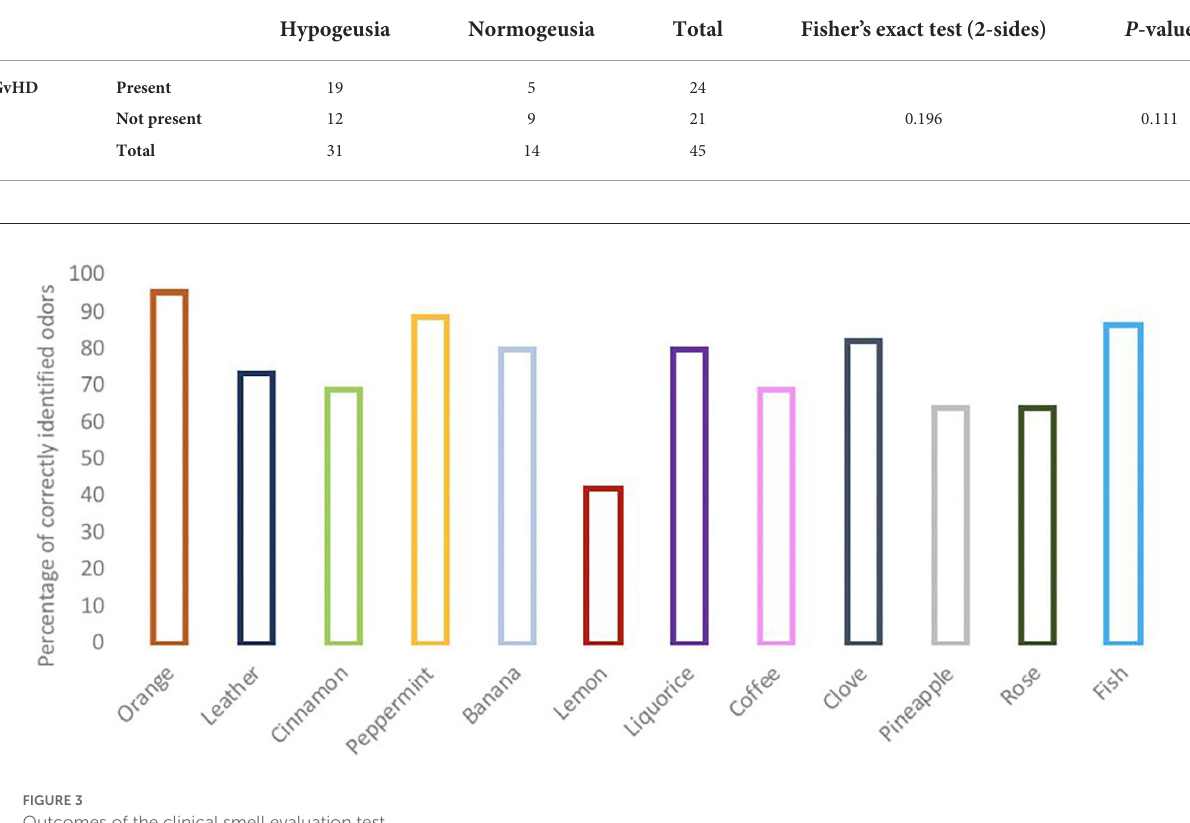
always aware of their altered taste sense. Not all noticed reduced taste